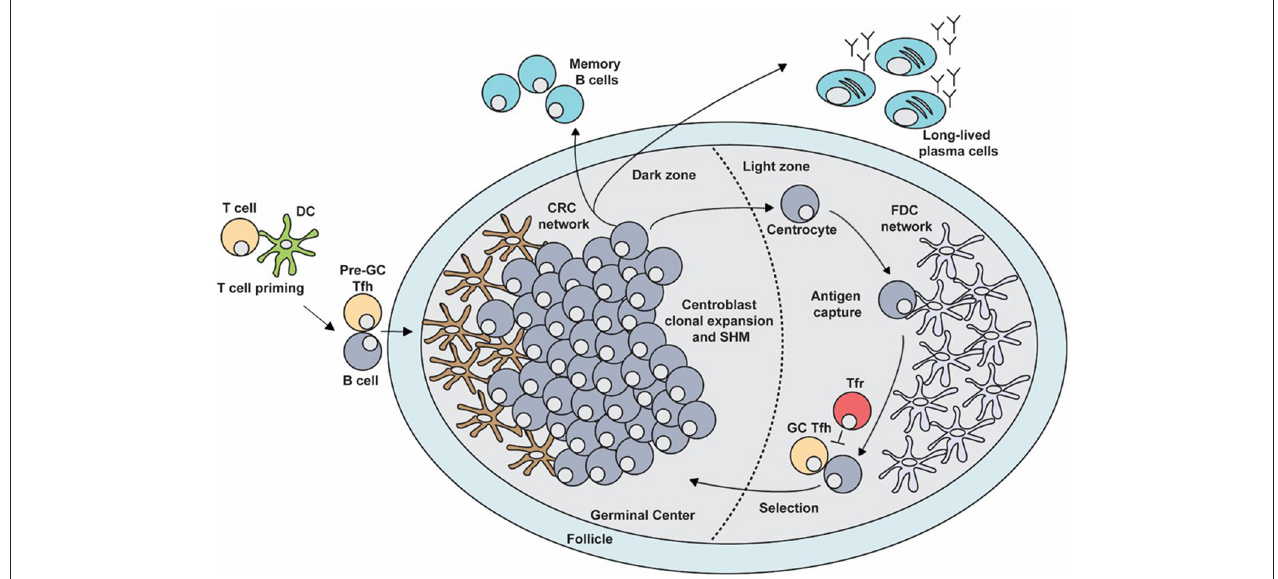
FIGURE 1 | The germinal center (GC) response. The GC is a specialized microenvironment formed within the B cell follicles of secondary lymphoid tissues upon infection or immunization. The GC is divided into two distinct compartments. The dark zone (DZ) that contains a network of CXCL12-producing reticular cells (CRCs) and is the site of GC B cell proliferation and somatic hypermutation (SHM). Centroblasts then follow a CXCL13 gradient to enter the light zone (LZ) as centrocytes through their expression of CXCR5. In the LZ, centrocytes capture antigen presented on follicular dendritic cells (FDCs) which they internalize, process and subsequently present to T follicular helper (Tfh) cells in order to undergo selection. This process is regulated by T follicular regulatory (Tfr) cells which are also present in the LZ. Upon receiving survival signals from Tfh cells, centrocytes re-enter the DZ for further rounds of proliferation and SHM after which they exit the GC as memory B cells or high-affinity antibody-secreting plasma